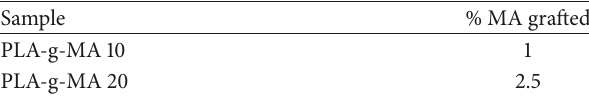
Table 2: Content of MA grafted on